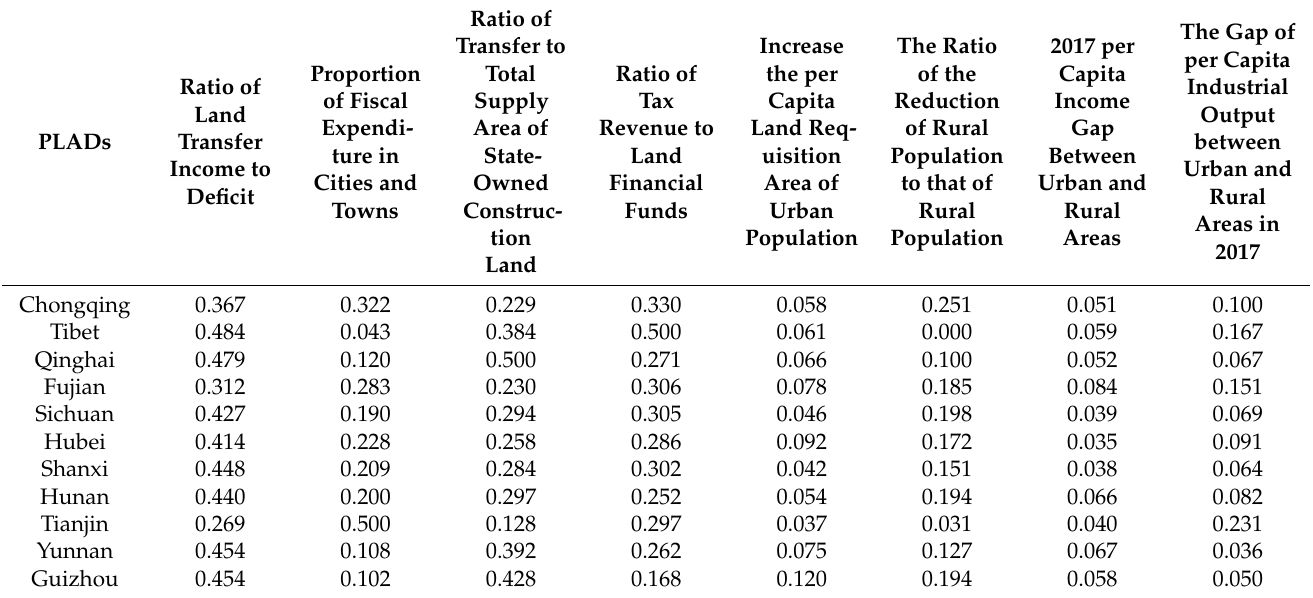
Table 3. Thirty-one PLADs’ land transfer income supports the weighted sum value of potential obstacles to rural